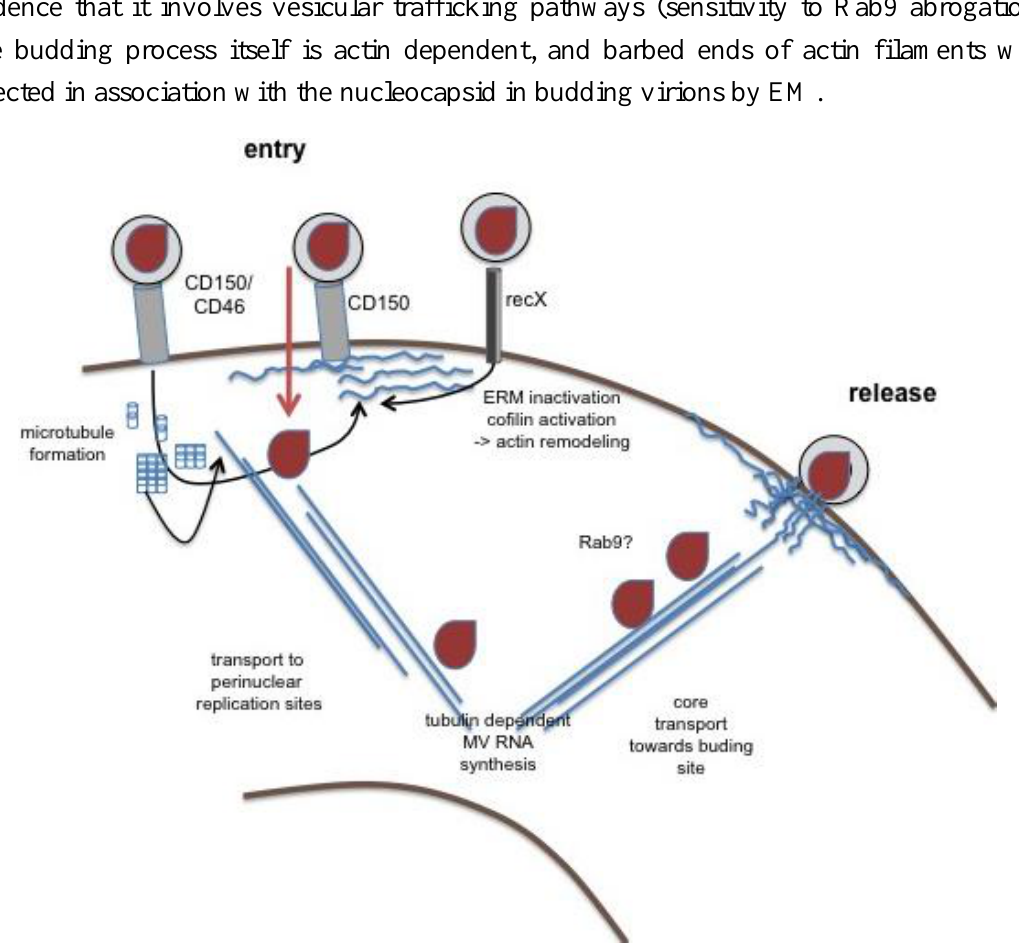
Figure 2. The role of the cytoskeleton in MV replication. Wild-type MV enters into hematopoetic cells after binding to CD150 (or CD46, middle structure). Not yet shown to occur in response to MV interaction, CD46 and CD150 can activate actin remodeling, on